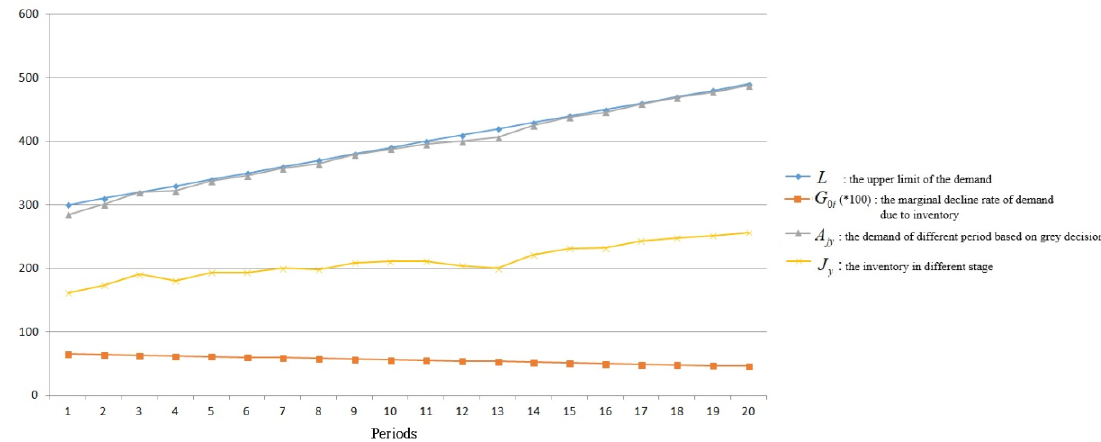
Figure 1. Grey correlation which probably encompasses the marginal utility.